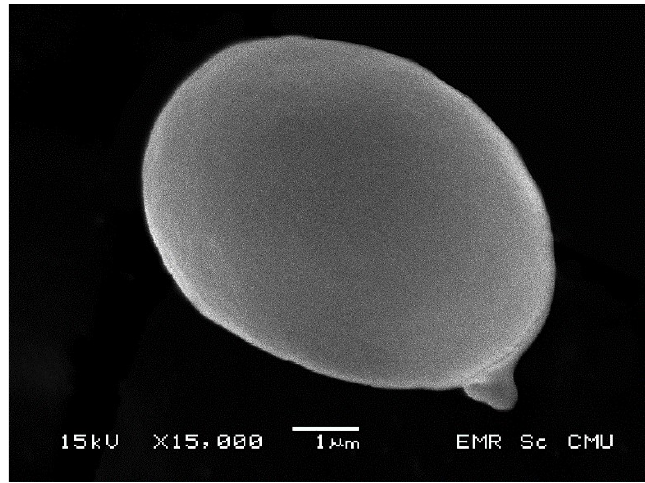
Figure 3 . Fresh basidiomata of Rubinosporus auriporus: ( A , B ) SV0090 (Holotype); ( C , D ) SV0394, spores deposit on the cap showing dark ruby color (white arrow); ( E ) SV0396; ( F ) the golden yellow pores, irregularly reddish brown at places in (SV0394)—Bars ( A – E ) = 1, ( F ) = 5 mm.